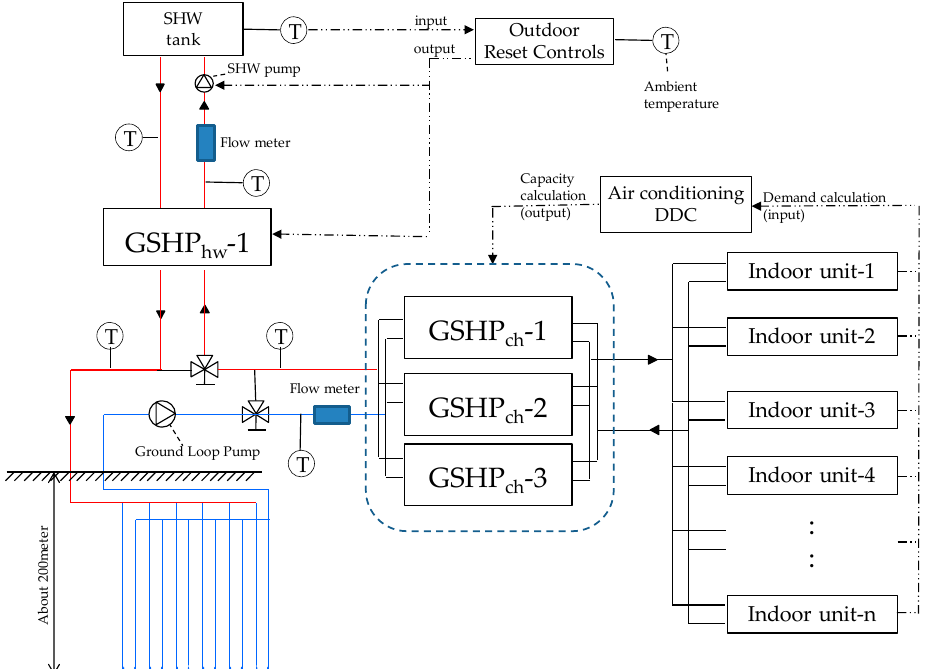
Figure5. Monitoringandcontrolpointsoftheintegratedgeothermalsystem; Figure 5. Monitoring and control points of the integrated geothermal system; (T) denotes thermopockets.